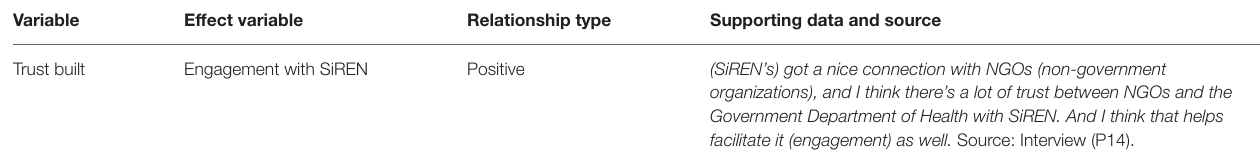
TABLE 1 | Coding table example.